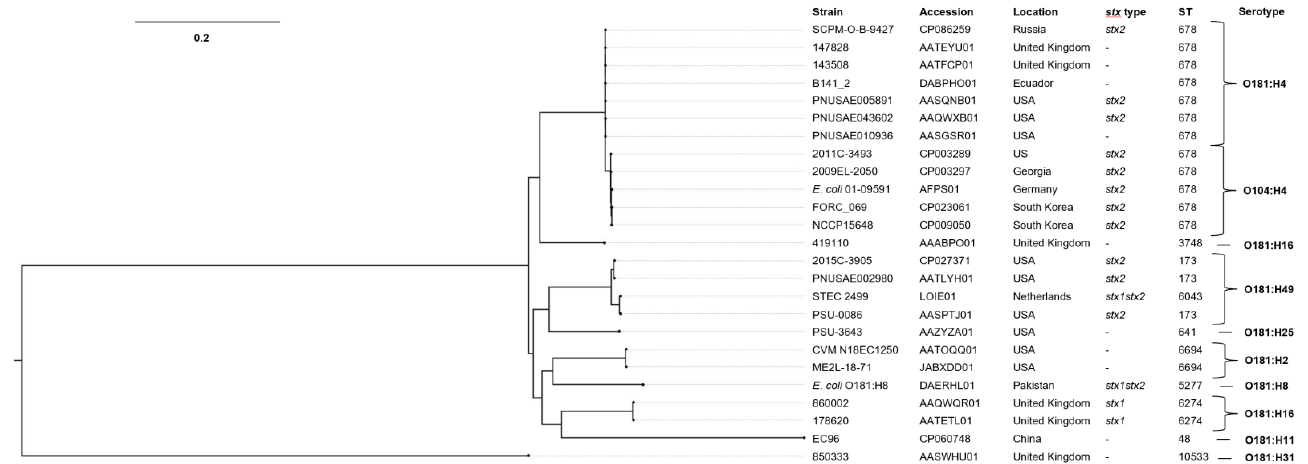
Figure 5. Neighbor-joining phylogenetic tree based on core SNPs, showing the phylogenetic relationship between chromosomes of EAHEC strain SCPM-O-B-9427 and E. coli O104:H4 and E. coli O181 strains. The scale bar shows the expected number of substitutions per site. Bar, 0.2 substitutions per nucleotide position.